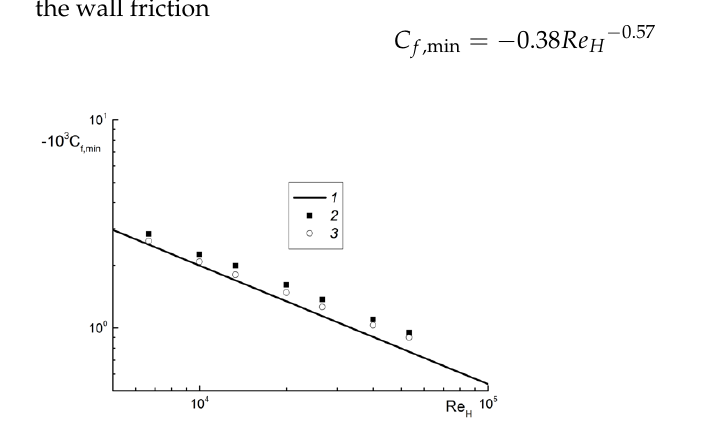
Figure 3. The value of the wall friction coefficient in the recirculation region as a function of the Reynolds number. 1 : semi-empirical correlation of for the single-phase flow [37]; 2: M L 1 = 0 (single-phase flow); 3 : 0.05.